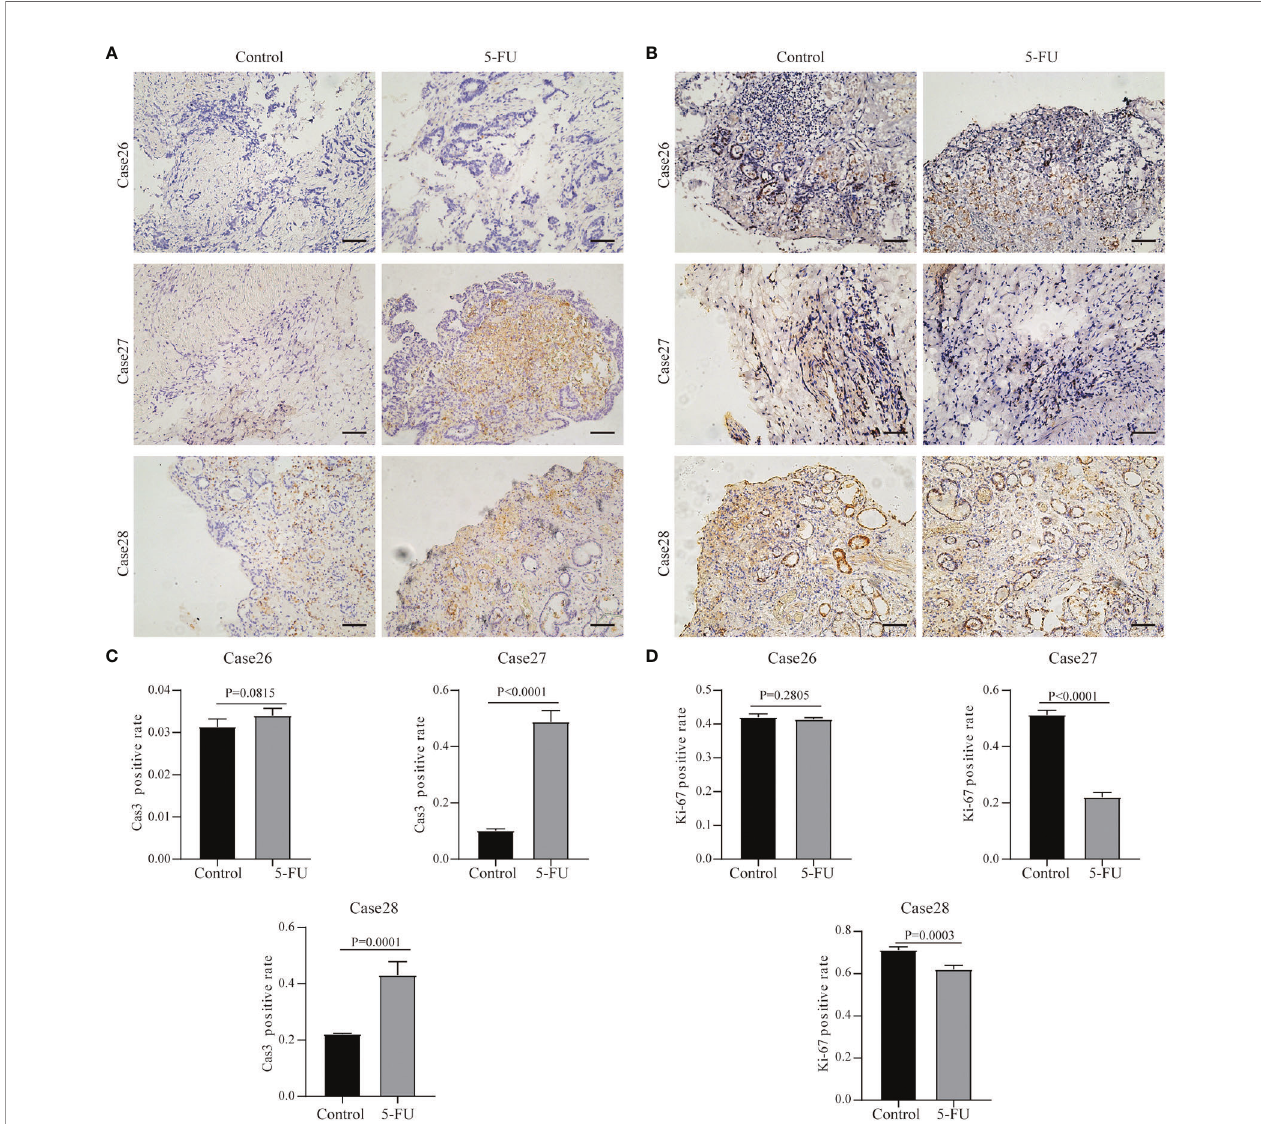
FIGURE 7 | Results of drug response tests to 5-FU based on 3D GC tissue culture. (A) The tumor tissues of Case26, Case27, and Case28 were stained with Cas3 after 3 days of culture and 5-FU treatment. (B) The tumor tissues of Case26, Case27, and Case28 were stained with Ki67 after 3 days of culture and 5-FU treatment. All images are the same magni fi cation, scale bar, 100 m m. (C, D) Quantitative analysis of Ki67 and Cas3 in tissues of